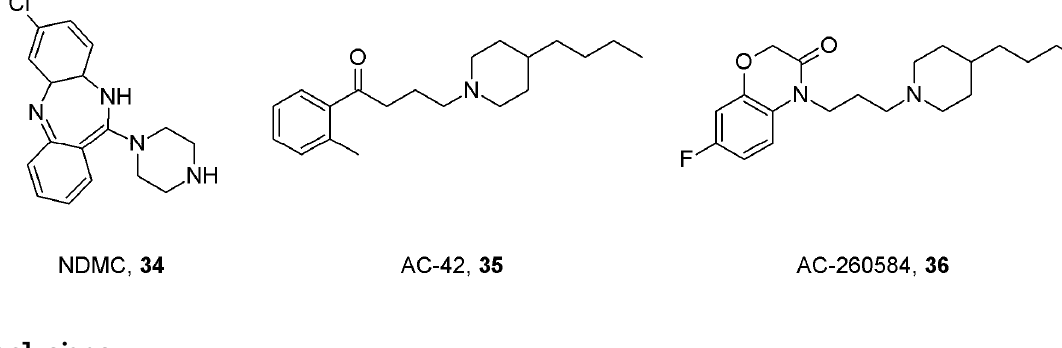
Figure 10. Structures of muscarinic ectopic